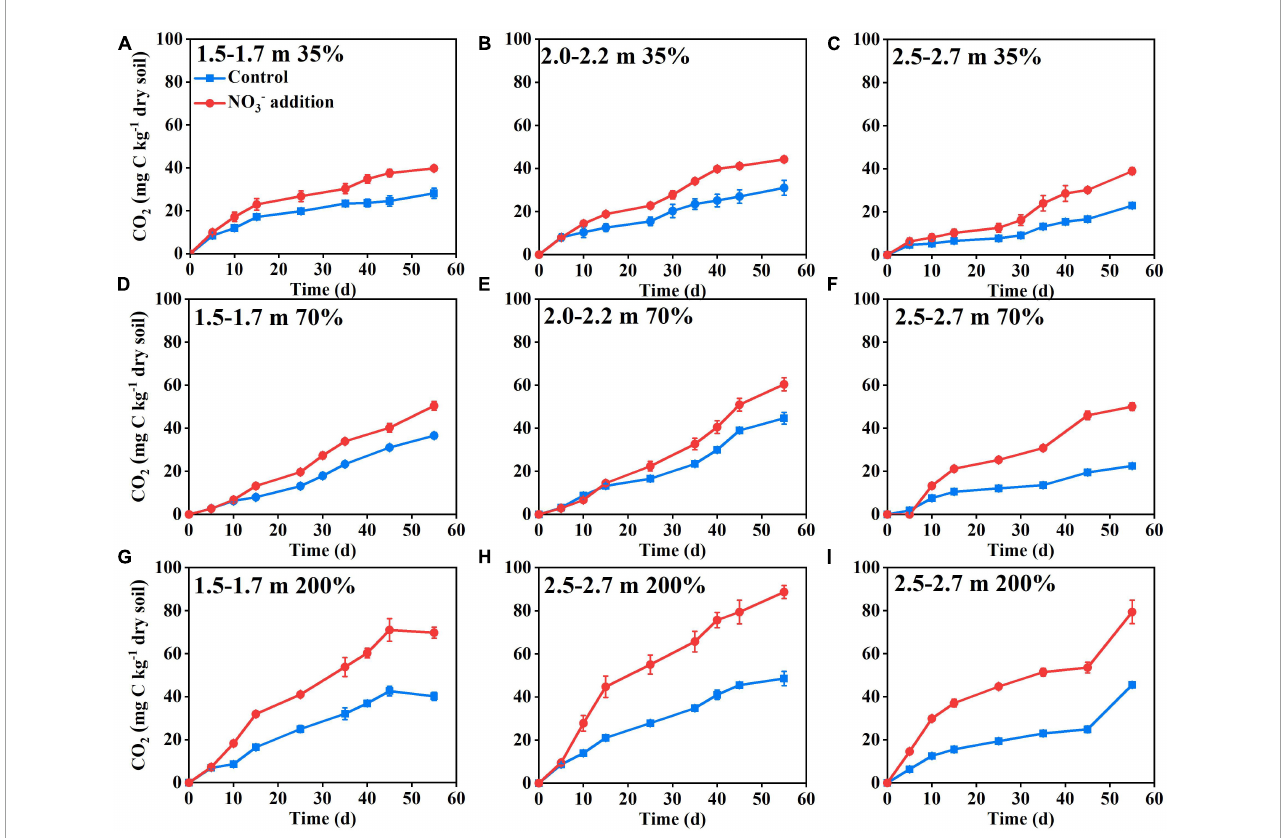
FIGURE1 Nitrate addition effects on the cumulative CO 2 emissions from deep soil depths: 1.5–1.7 m (A,D,G) , 2.0–2.2 m (B,E,H) , and 2.5–2.7 m (C,F,I) with soil gravimetric water contents of 35% (A–C) , 70% (D–F) , and 200% (G–I) in Experiment 1. The blue lines and red lines represent control and nitrate addition treatments, respectively. Data are shown as the mean ± standard deviation ( n =